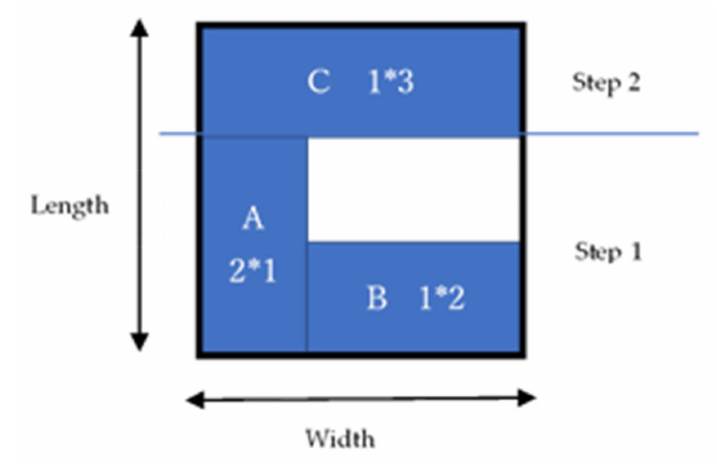
Figure 1. Example of